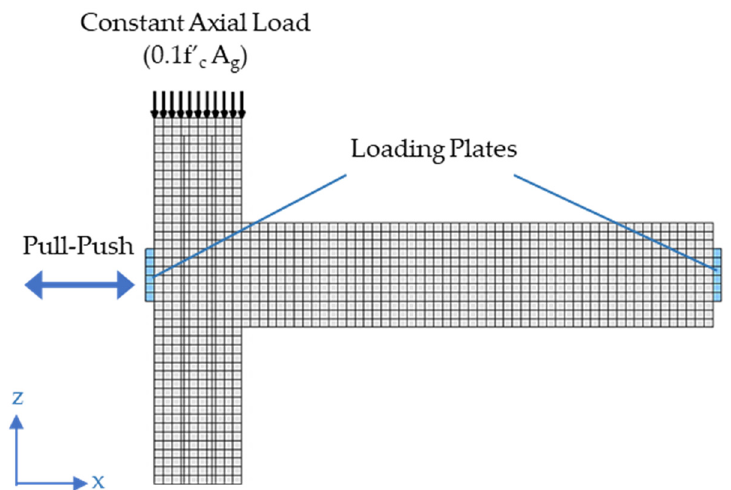
Figure 9. Loading scheme.